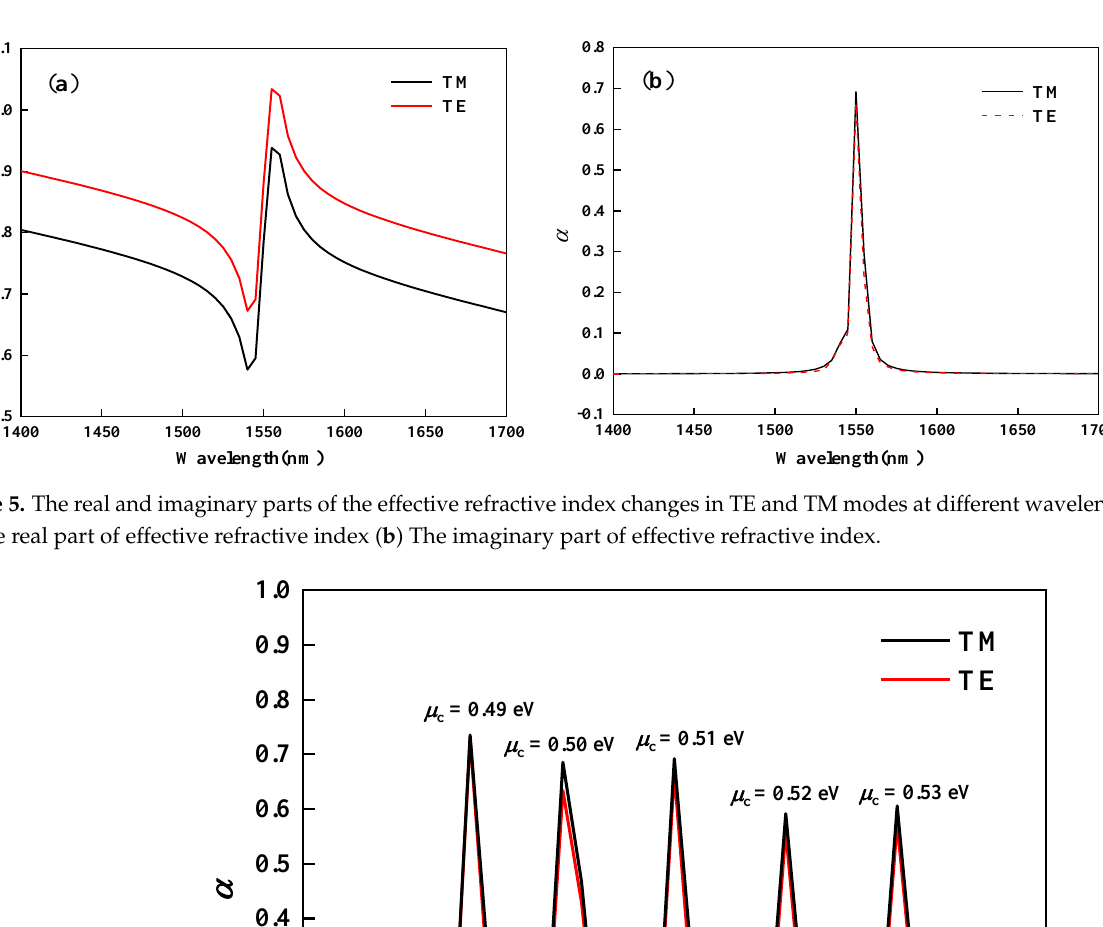
Figure 5. The real and imaginary parts of the effective refractive index changes in TE and TM modes at different wave- length ( a ) The real part of effective refractive index ( b ) The imaginary part of effective refractive index.